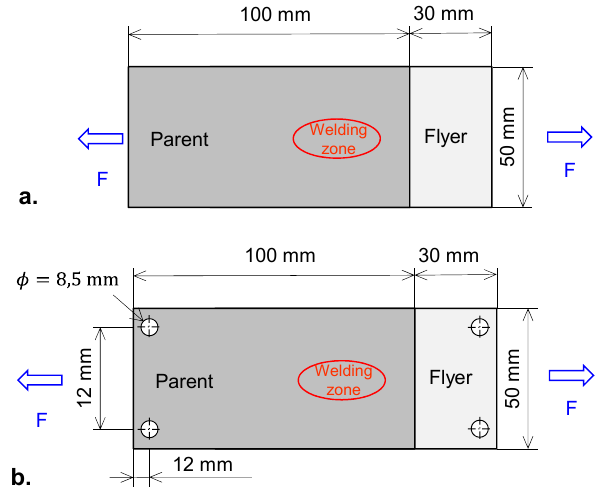
Figure 9. ( a ) quasi static and fatigue lap shear tests specimen, ( b ) dynamic lap-shear test specimen